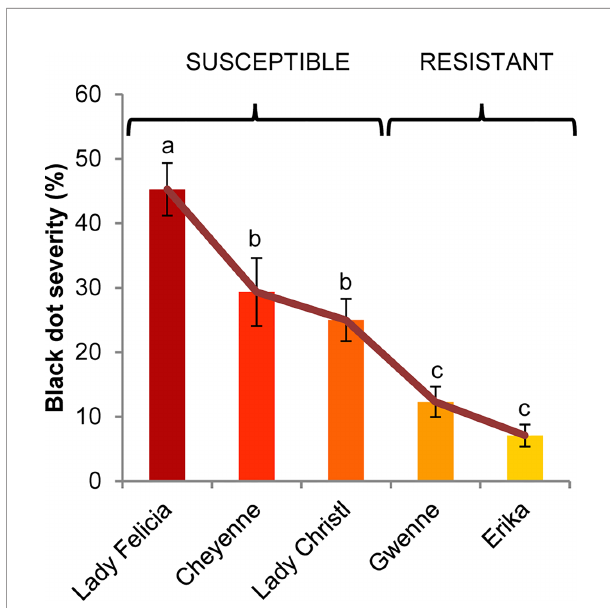
FIGURE 1 | Black dot disease severity of fi ve different potato cultivars arti fi cially inoculated with C. coccodes . Disease severity is expressed as the percentage of tuber area showing symptoms of black dot (Means ± Standard Error, n=30). Statistically signi fi cant differences are indicated by different letters (p < 0.05, Fisher ’ s LSD